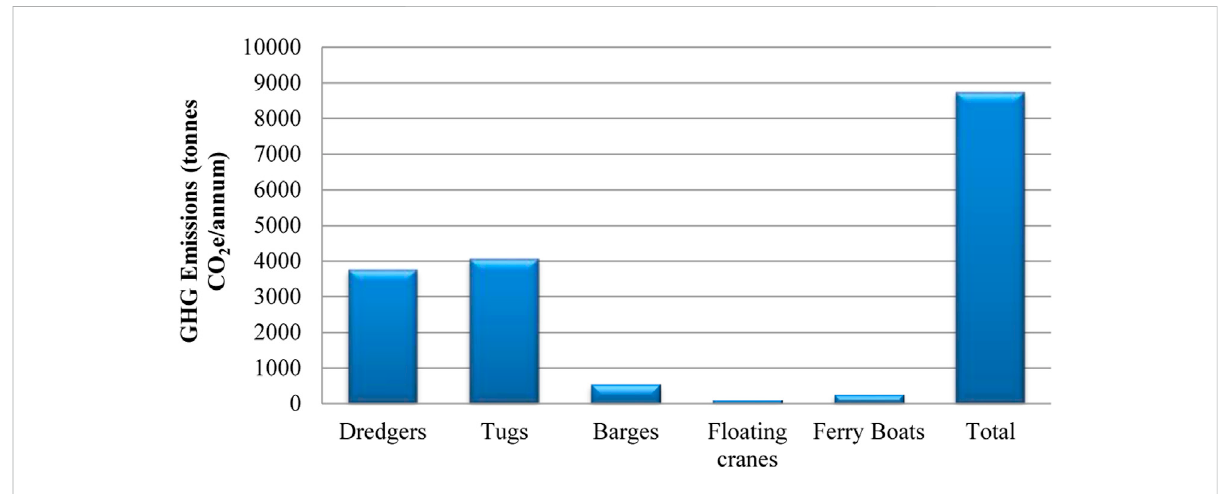
FIGURE 9 Total annual GHG emissions (CO 2 e) from harbour crafts of KPT.